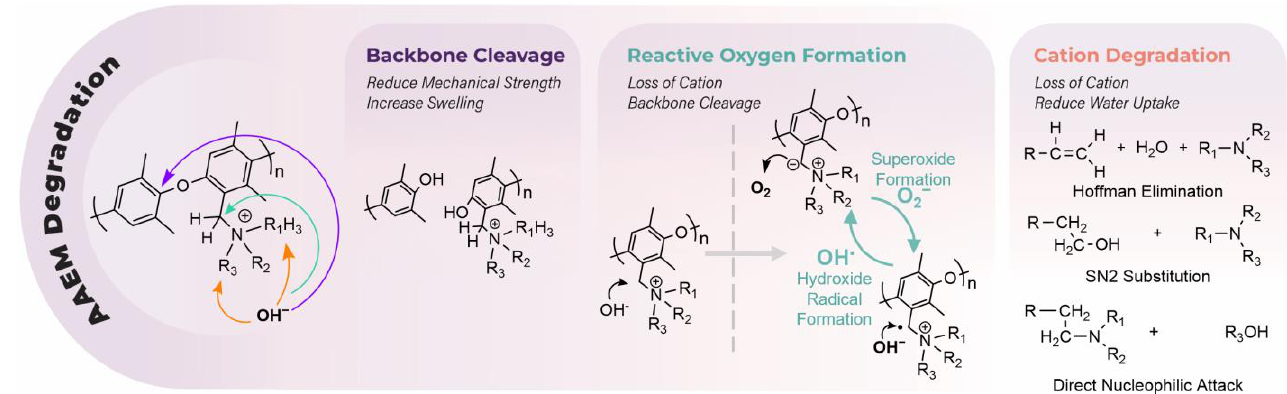
Figure 8. Primary degradation pathways of quaternary amine cation head groups.